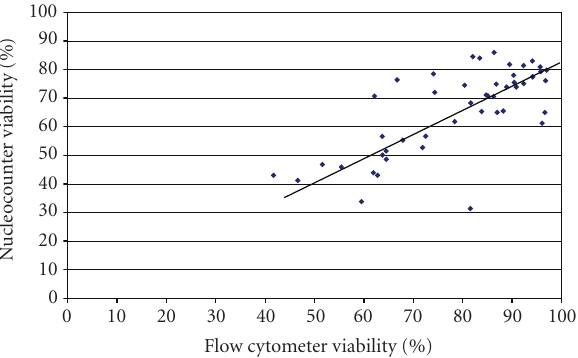
Figure 2: Comparison of viability results using the flow cytometer and the Nucleocounter SP-100 ( n = 60).